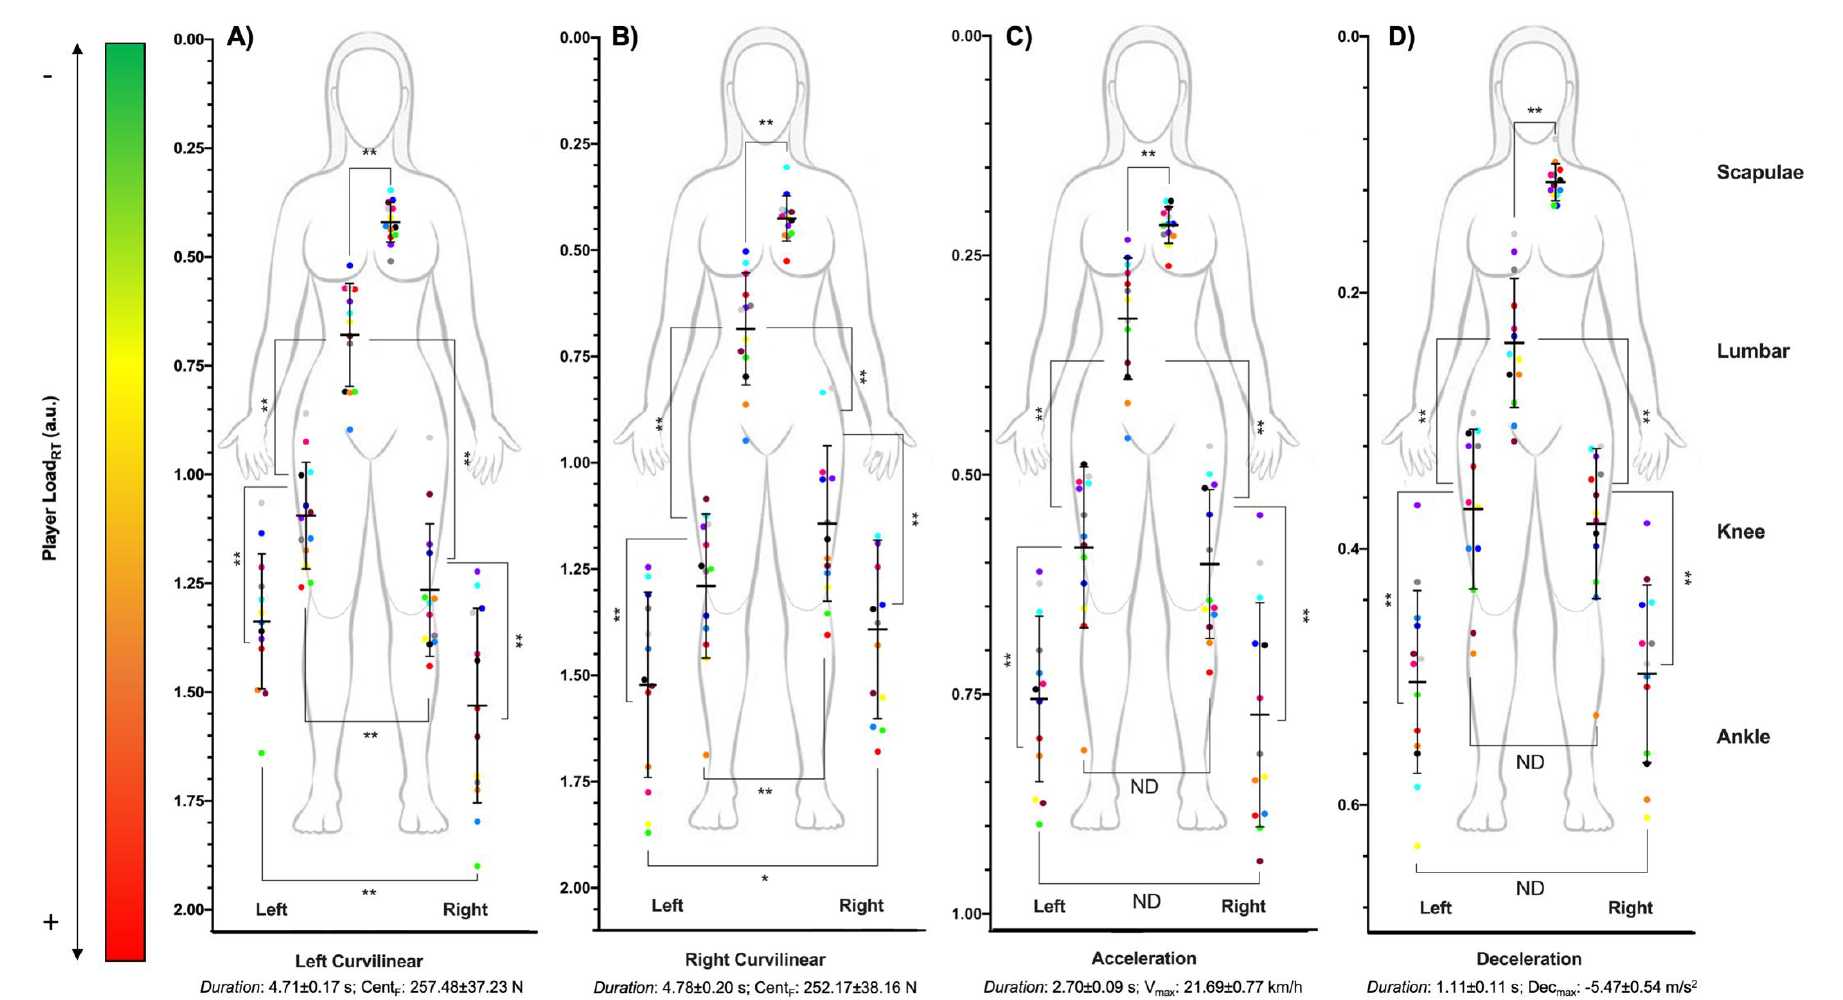
Figure 2. Multi-location external workload profile of semi-professional women’s basketball players in curvilinear locomotion (( A ) left and ( B ) right direction) and speed changes (( C ) acceleration and ( D ) deceleration). ** Statistical differences ( p < 0.01); * Statistical differences ( p < 0.05); ND: No statistical differences.